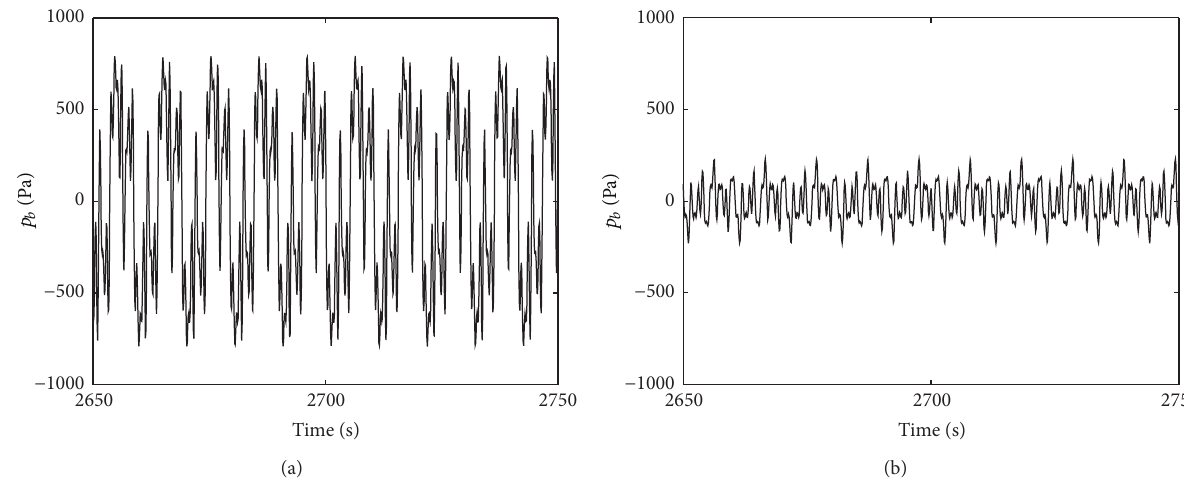
Figure 4: Calculations of the dynamic bottom pressure at both sides of the trench; at 𝑥 = −𝜖 (a) and 𝑥 = 𝐿 + 𝜖 (b), where 𝜖 ≪ 1 .